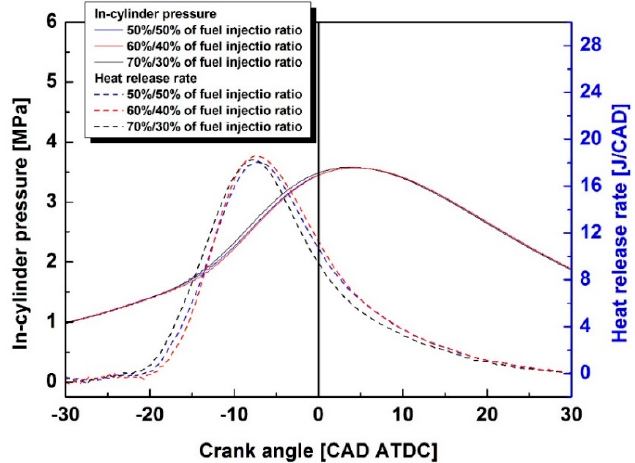
Figure 7. Comparison of in-cylinder pressure traces and heat release rate for the fuel injection ratio of 50%/50%, 60%/40%, and 70%/30% with optimized fuel injection and SA timing at 1600 rpm and BMEP of 0.24 MPa.